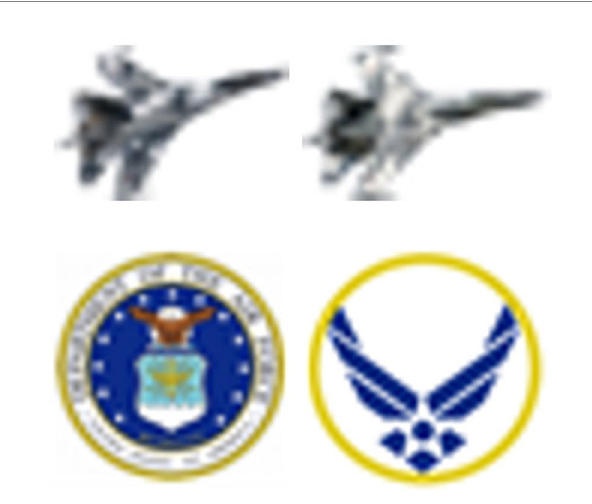
FIGURE 3 (Top) The two possible central targets. (Bottom) The two peripheral targets: (left) common; (right) unique. Adapted with permission from USAFRL.